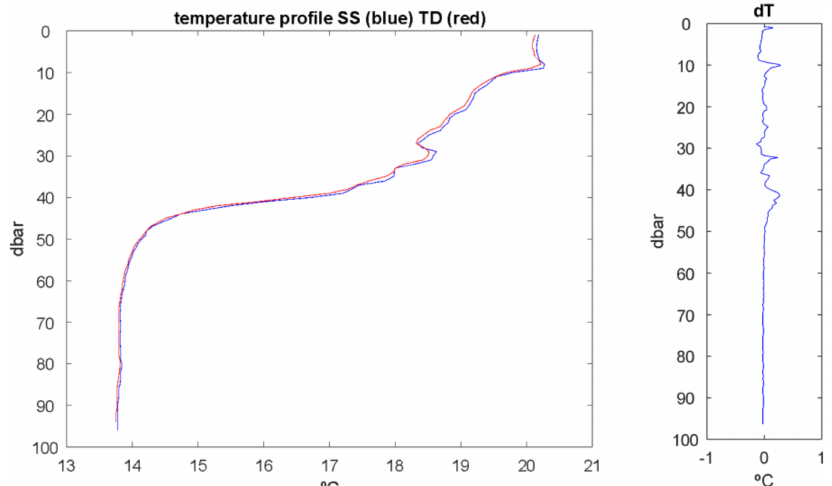
Figure 5. ( Left ) Temperature profiles obtained with the SPV TD profiler (red curve) and with the Sea & Sun CTD 48Mc (blue) and ( right ) their difference (CTD minus TD values).